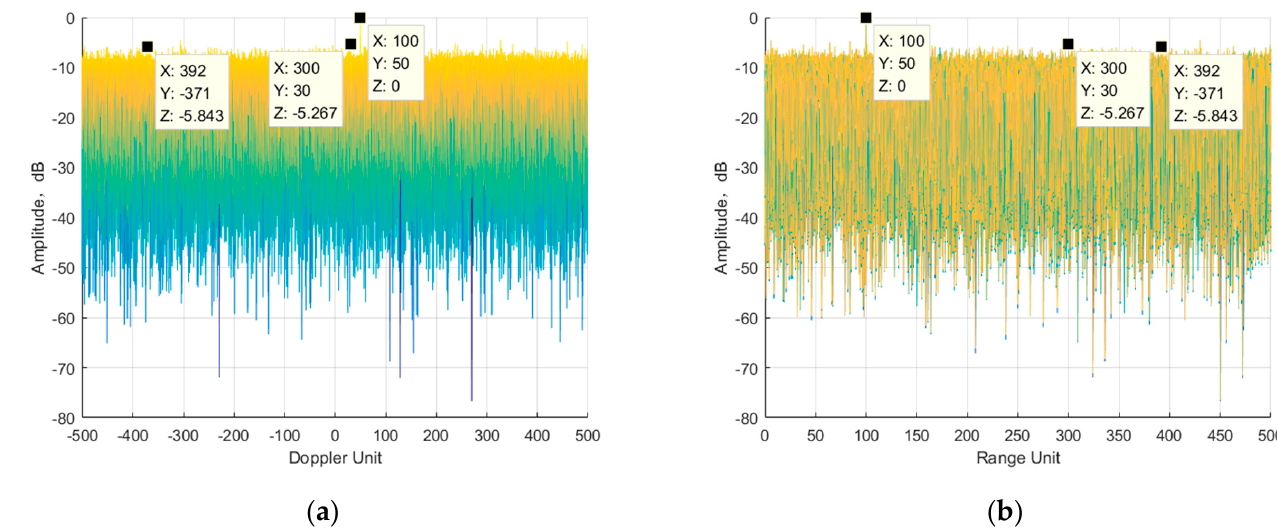
Figure 2. Integration results with traditional R-D processing: N = 10 4 ( a ) Doppler dimension; ( b ) Range dimension.